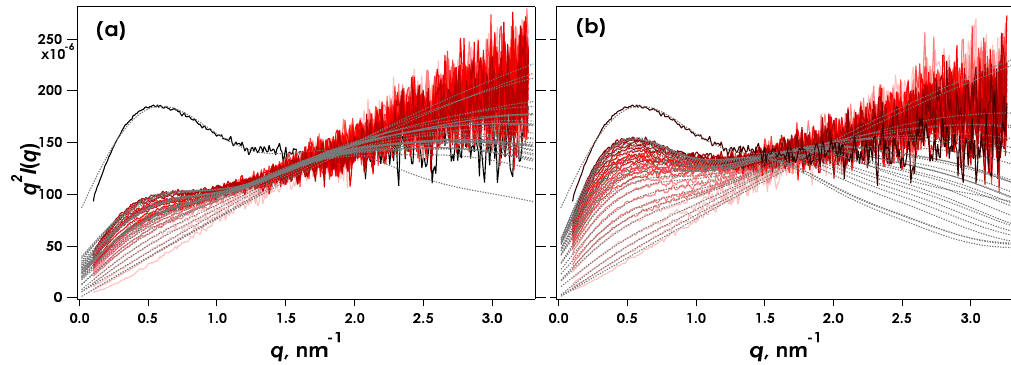
Figure 3. Kratky plots obtained for time-resolved SAXS during CLEX gelation of 1% alginate in aqueous MOPS buffer including CaEDTA and ZnEDDA at Ca 2+ = 30 mM and pH = 7.0. The results ( a ) and ( b ) correspond to independent measurements under the same experimental conditions. The profiles show data recorded every 5 s and the total trace times are 145 and 130 s for ( a ) and ( b ) respectively. Solid black lines indicate SAXS obtained from fully reacted samples following 10 h reaction time.